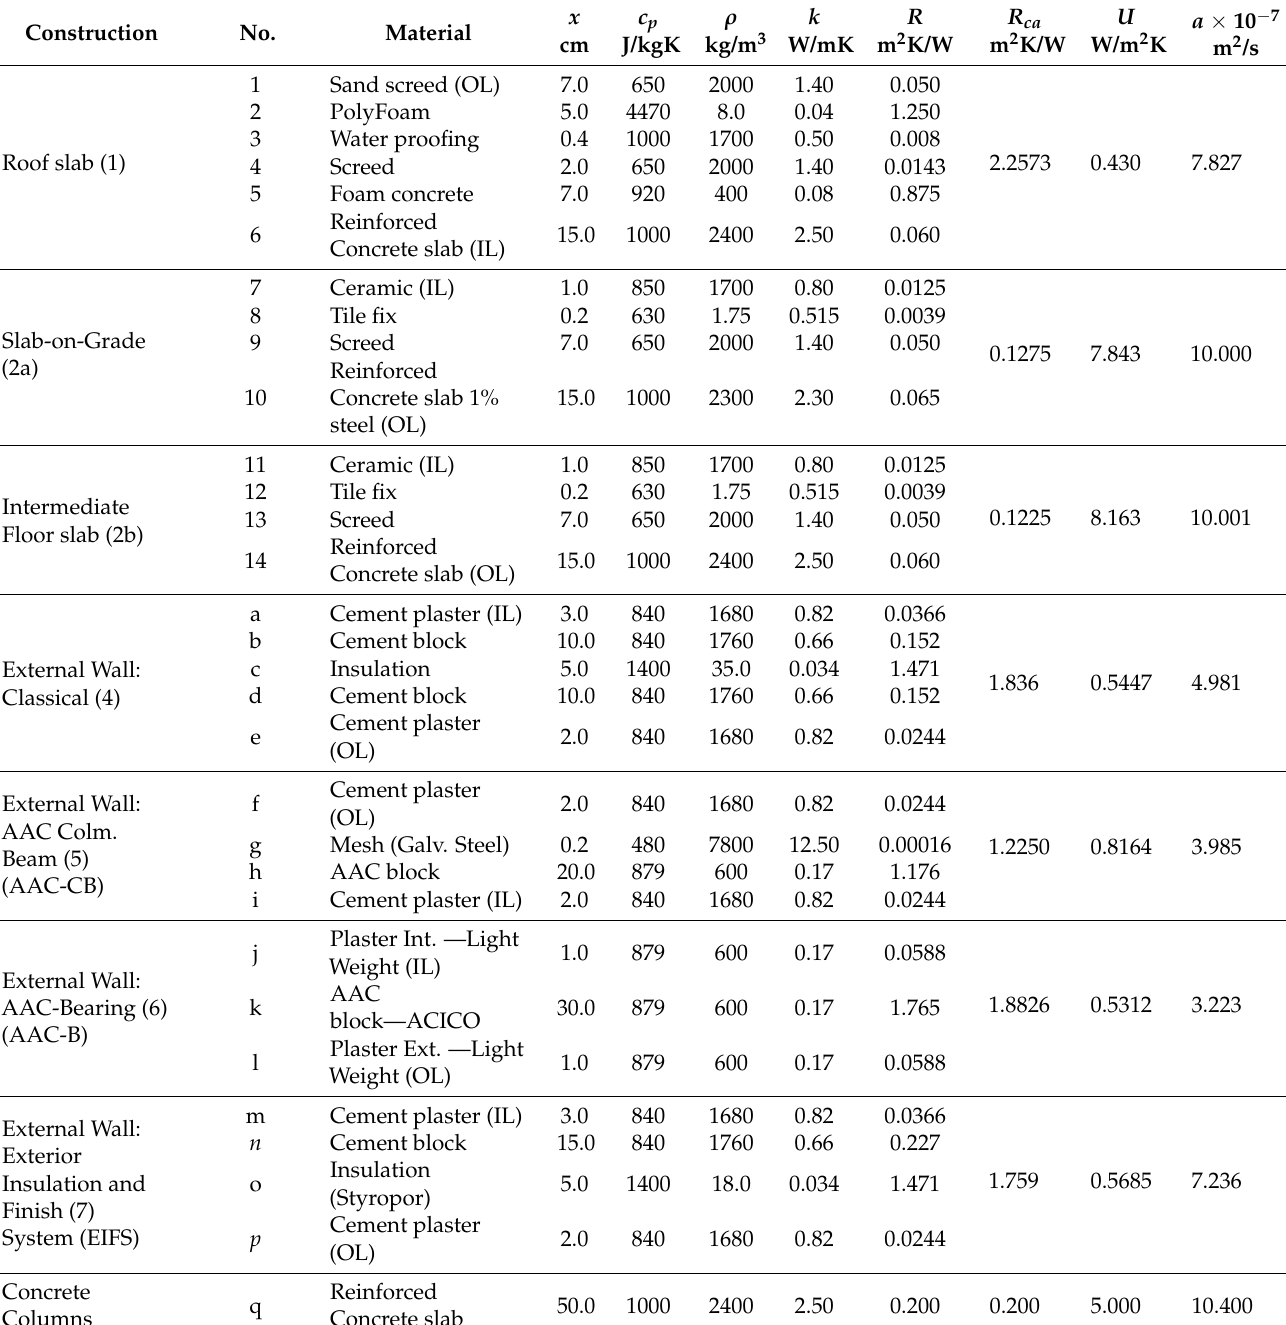
Table 1. Characteristics of the residential building envelope components (walls, slabs, and